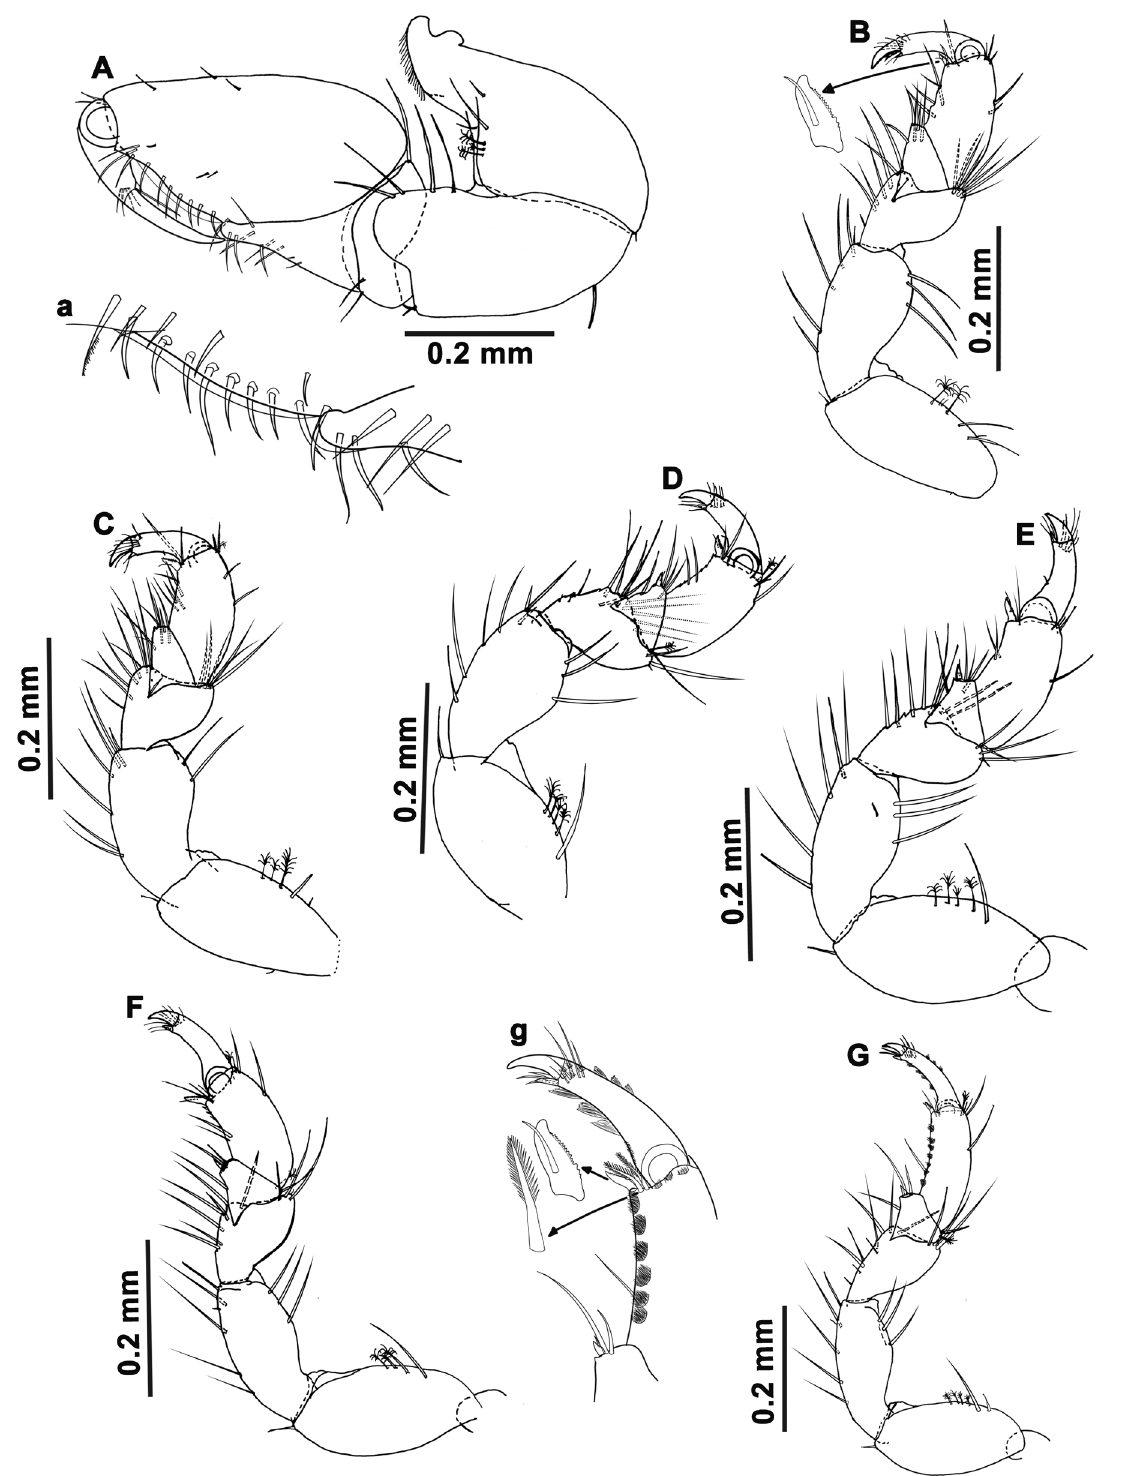
Fig. 18. Tinggianthura mexicana sp. nov., holotype, ♀, 3.7 mm, Oaxaca, Huatulco, El Maguey Bay (UMAR-PERA 561). A . Pereopod 1 and detail of the palm (a). B . Pereopod 2 and detail of the sensory spine. C . Pereopod 3. D . Pereopod 4. E . Pereopod 5. F . Pereopod 6. G . Pereopod 7 and detail of propodus and dactylus